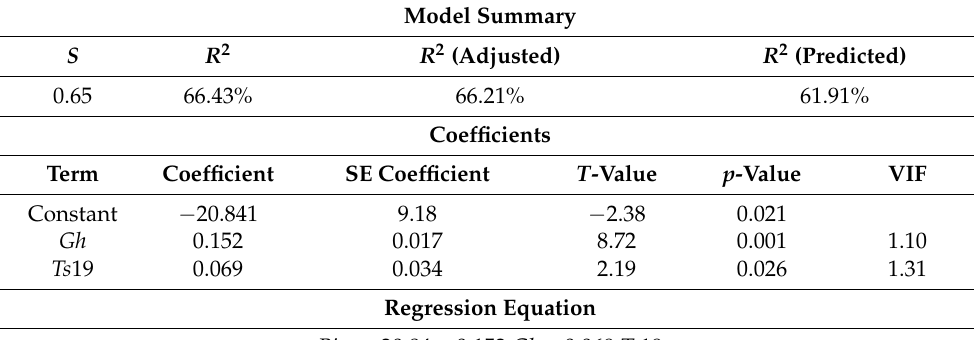
Table 5. Model summary for mod-still (Model 1).